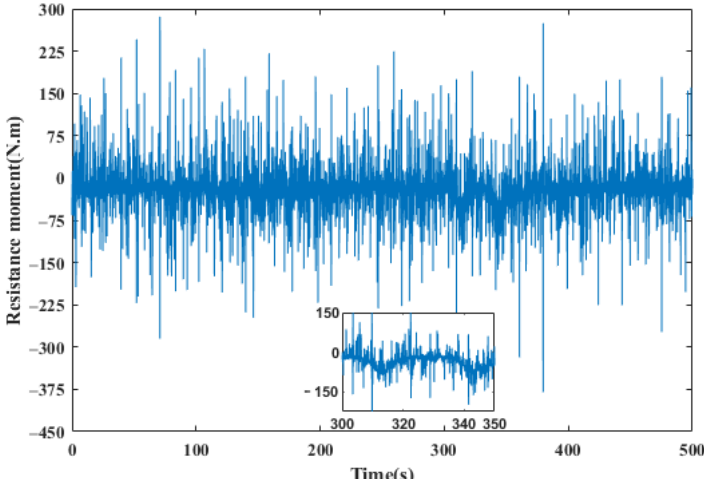
Figure 20. Oil pressure detection diagram for sloping terrain.